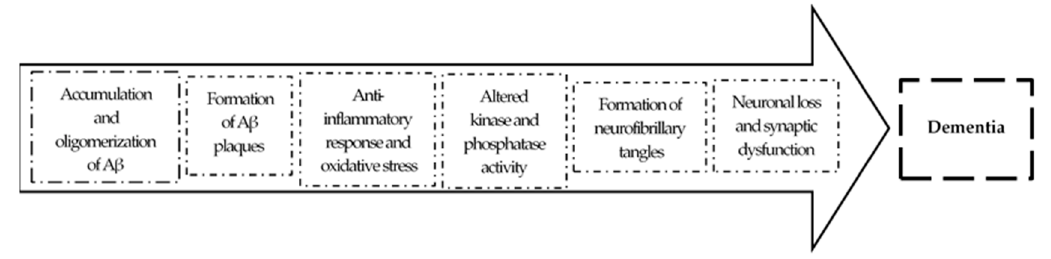
Figure 2. Cascade of events according the amyloid hypothesis. Adapted from [16].